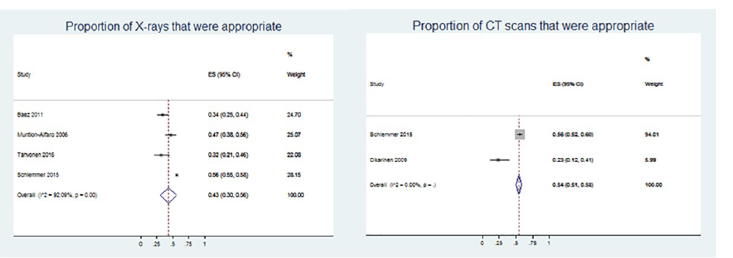
Fig 3. Meta-analysis for proportion of appropriate x-rays and CT scans for low back